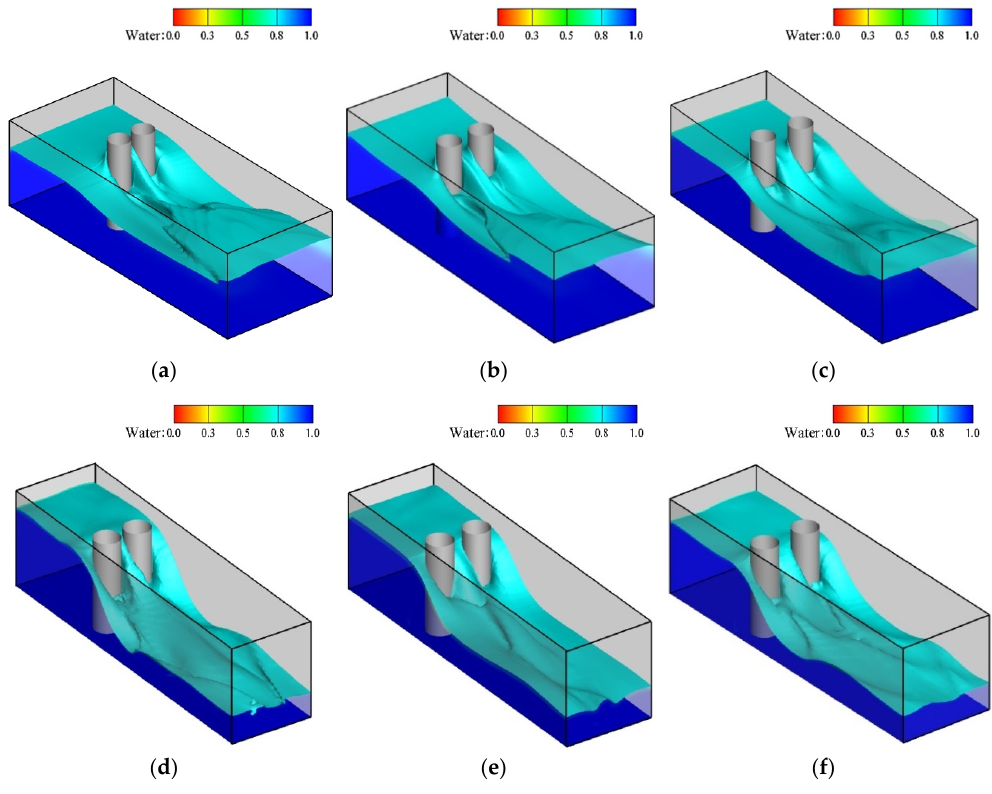
Figure 8. Free ‐ surface shape at different gap ratios: T / D = 1.25, 1.50, and 1.75. The distances between the cylinder and side wall are 8.0 D ( a – c ) and 1.0 D ( d – f ).